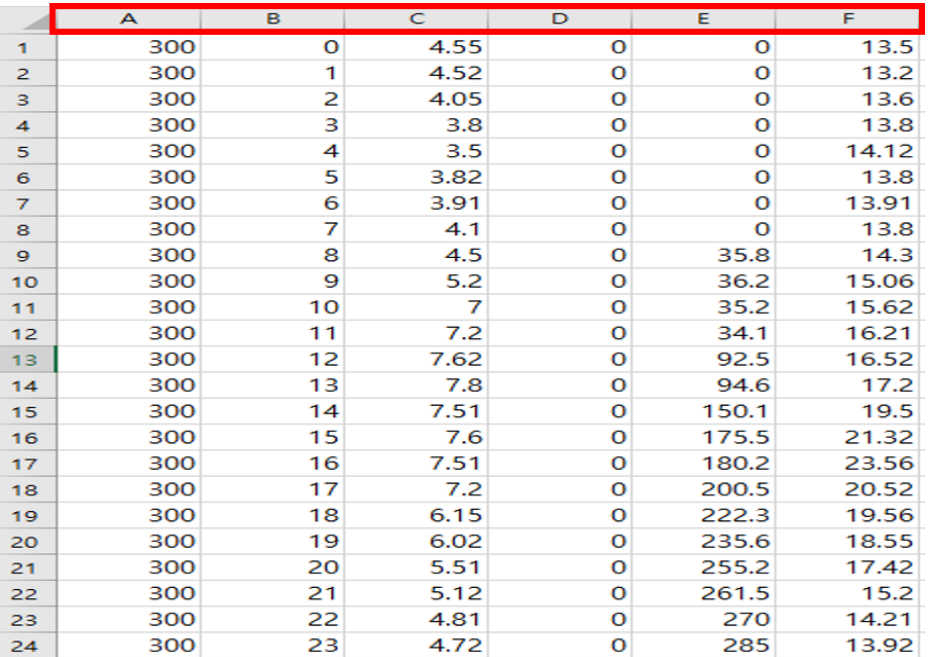
Figure 12. Basic architecture of the recurrent neural network. The green boxes indicate hidden states (h), the red box is the input (x), and the blue box is the output (y). The current hidden state (h t ) is updated by using the previous hidden state (h t − 1 ). The current output (y t ) is updated using h t , as shown by the formula.